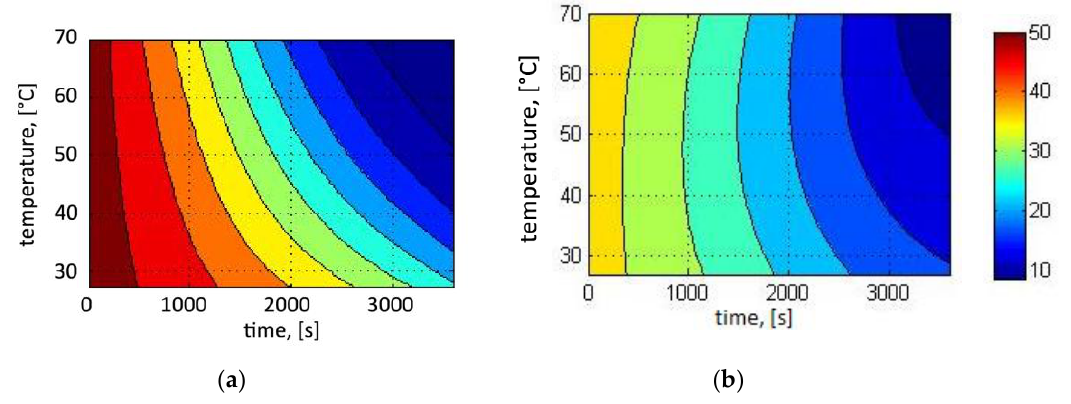
Figure 19. Plane diagram of the drying process, 3D installation; Turów; 0–8 mm; temperature 27–50